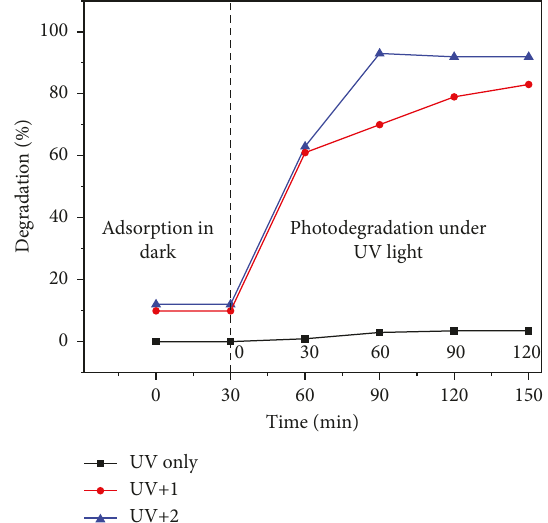
Figure 7: Degradation efficiency of complexes (1) and (2) against Congo red dye under UV light irradiation.